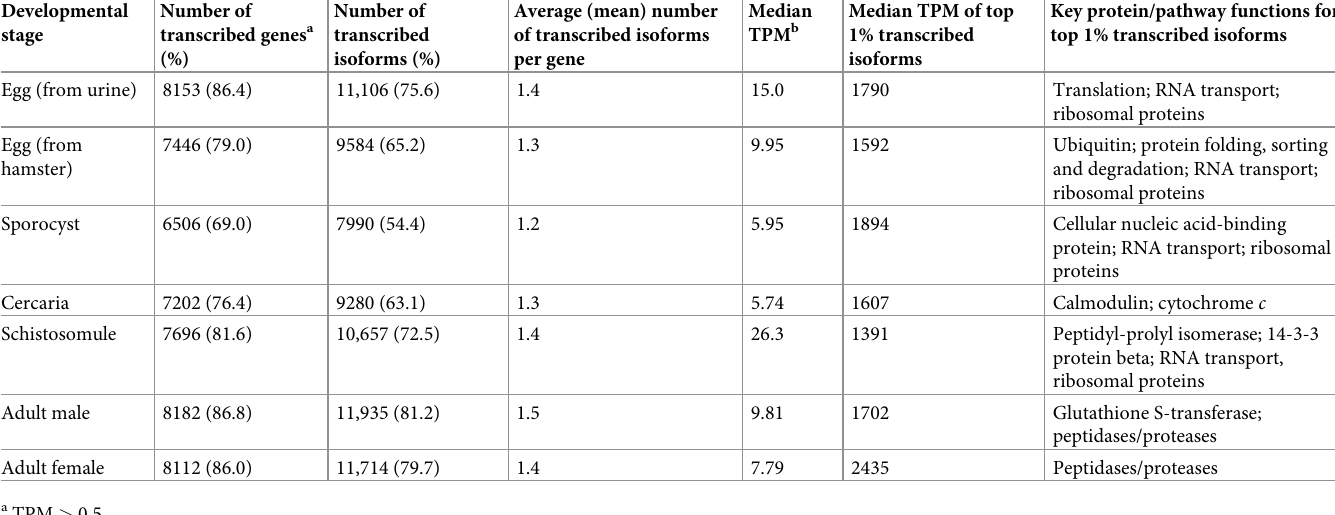
Table 4. Summary of transcription levels across seven key developmental stages of Schistosoma haematobium . Developmental stage